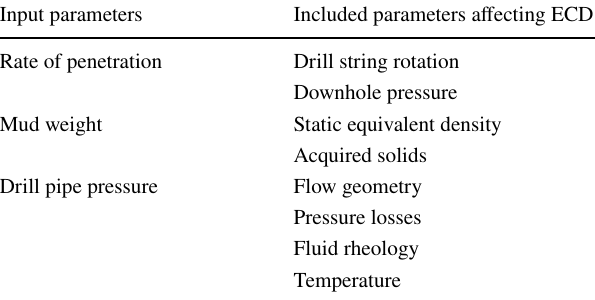
Table 1 Parameters affecting ECD aligned with selected input param-